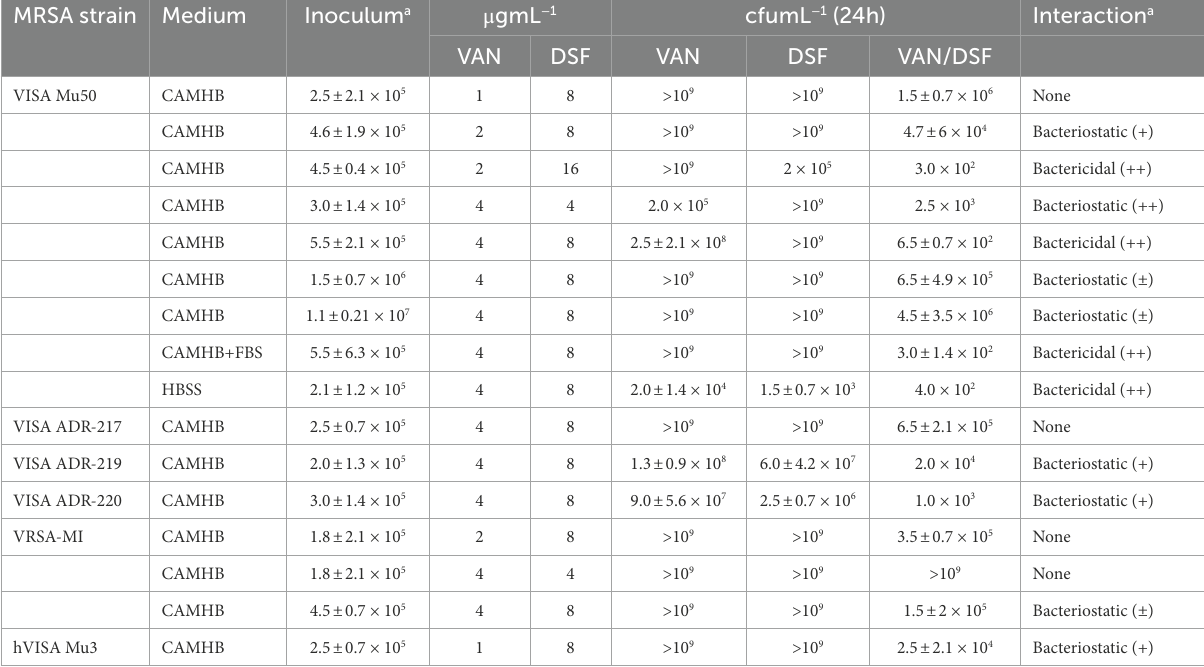
TABLE 2 Effects of VAN, DSF, and combined treatments on cfu mL − 1 counts after 24 h.